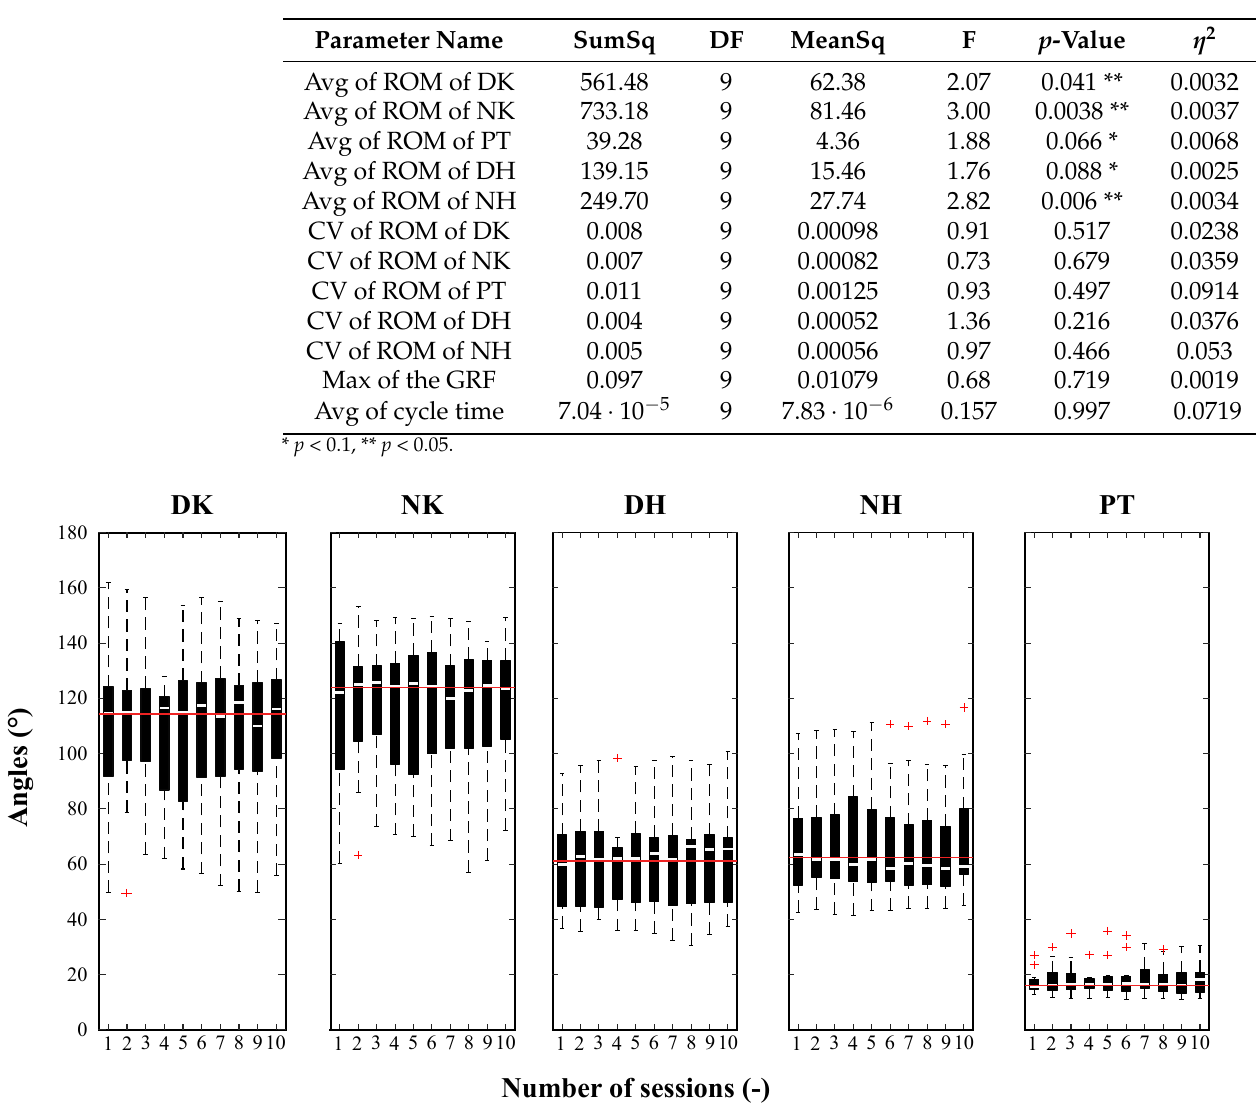
the significant changes in the motion parameters during the dancing sessions.